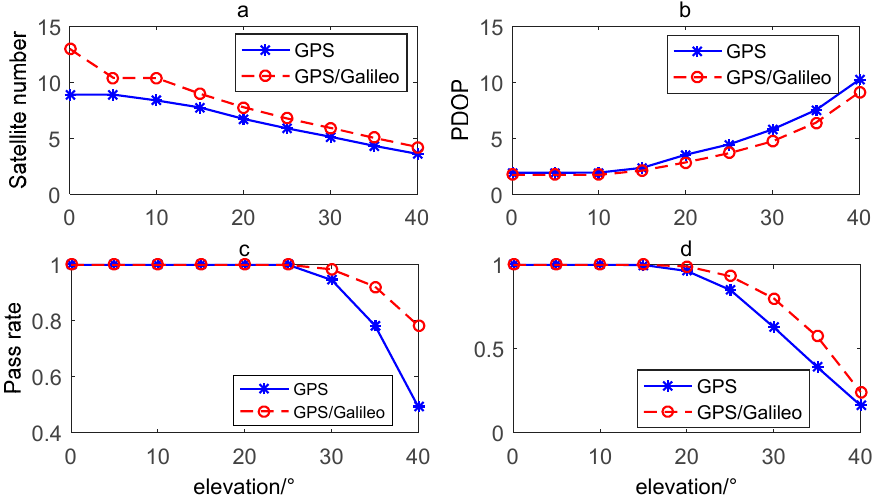
Figure 4. The satellite visibility, Position Dilution of Precision (PDOP), and their pass rate curves of GPS and GPS/Galileo under different cutoff angles ( ◦ ): ( a ) The satellite visibility; ( b ) PDOP; ( c ) Pass rate of GPS under different cutoff angles ( d ) Pass rate of GPS/Galileo under different cutoff angles. Table 2. The visibility, PDOP and their pass rate of GPS and GPS/Galileo under different cutoff angles ( ◦ ).